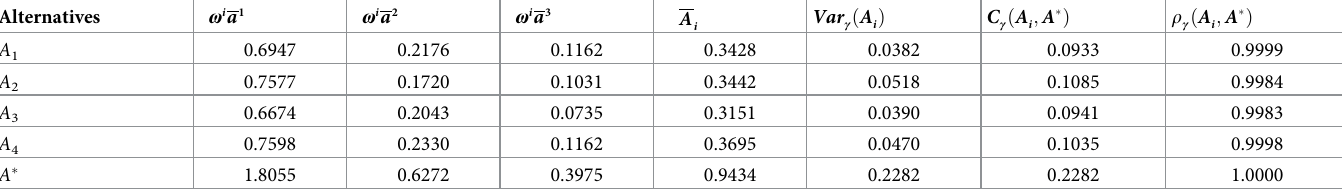
Table 6. Calculation results of ordered weighted correlation coefficients with respect to the BWM.